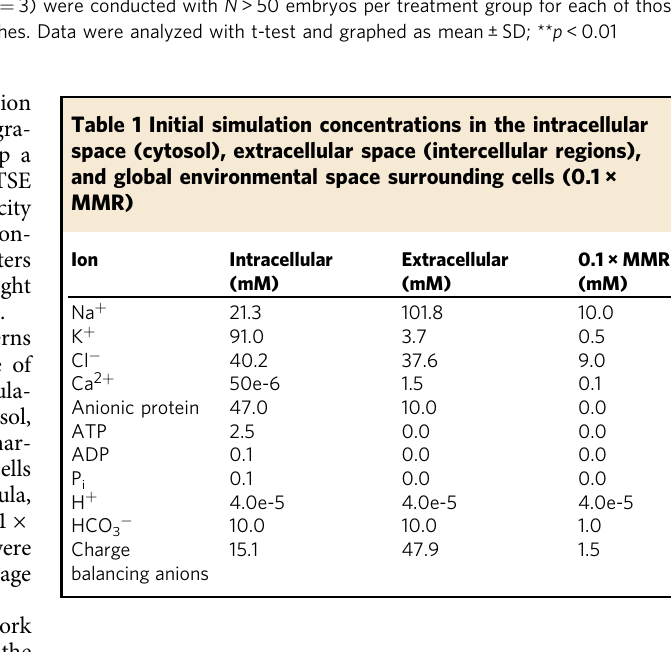
observed endogenous relative hyperpolarization in the neural tube compared to the neural folds and ectoderm. This results in open Kir channels in the hyperpolarized neural tube region leading to a V mem pattern of approximately − 50 mV in the neural tube region, while the lateral neural folds and ectoderm remain at ~ − 5 mV (Fig. 3a, e). This hypothesis of generation of the endogenous V mem pattern in the Xenopus neural tube is consistent with observed V mem patterns in Xenopus embryos and the effect of dominant-negative Kir channels on them 27,28 .